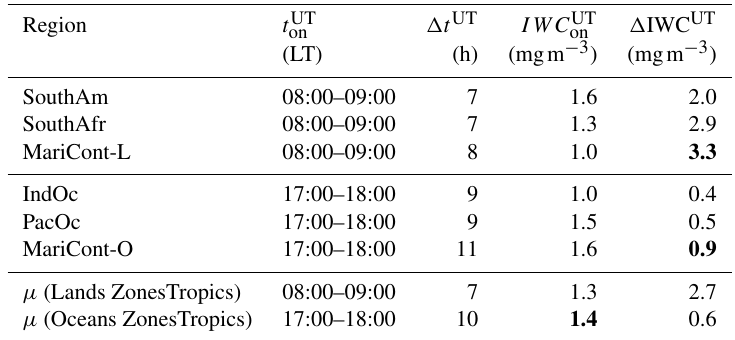
Table 3. Time of the onset of the ice injection in the tropical upper troposphere (UT), (t UT on ) , duration of the injection of ice in the UT ( (cid:49)t UT ), minimum amount of ice in the UT (IWC UT ), and amount of ice injected into the UT ( (cid:49) IWC UT ) as a function of the six study zones min and averaged over the land and ocean zones ( µ (Lands ZonesTropics) and µ (Oceans ZonesTropics), respectively) during DJF from 2004 to 2017. The bold values highlight the most important injection of ice and the associated